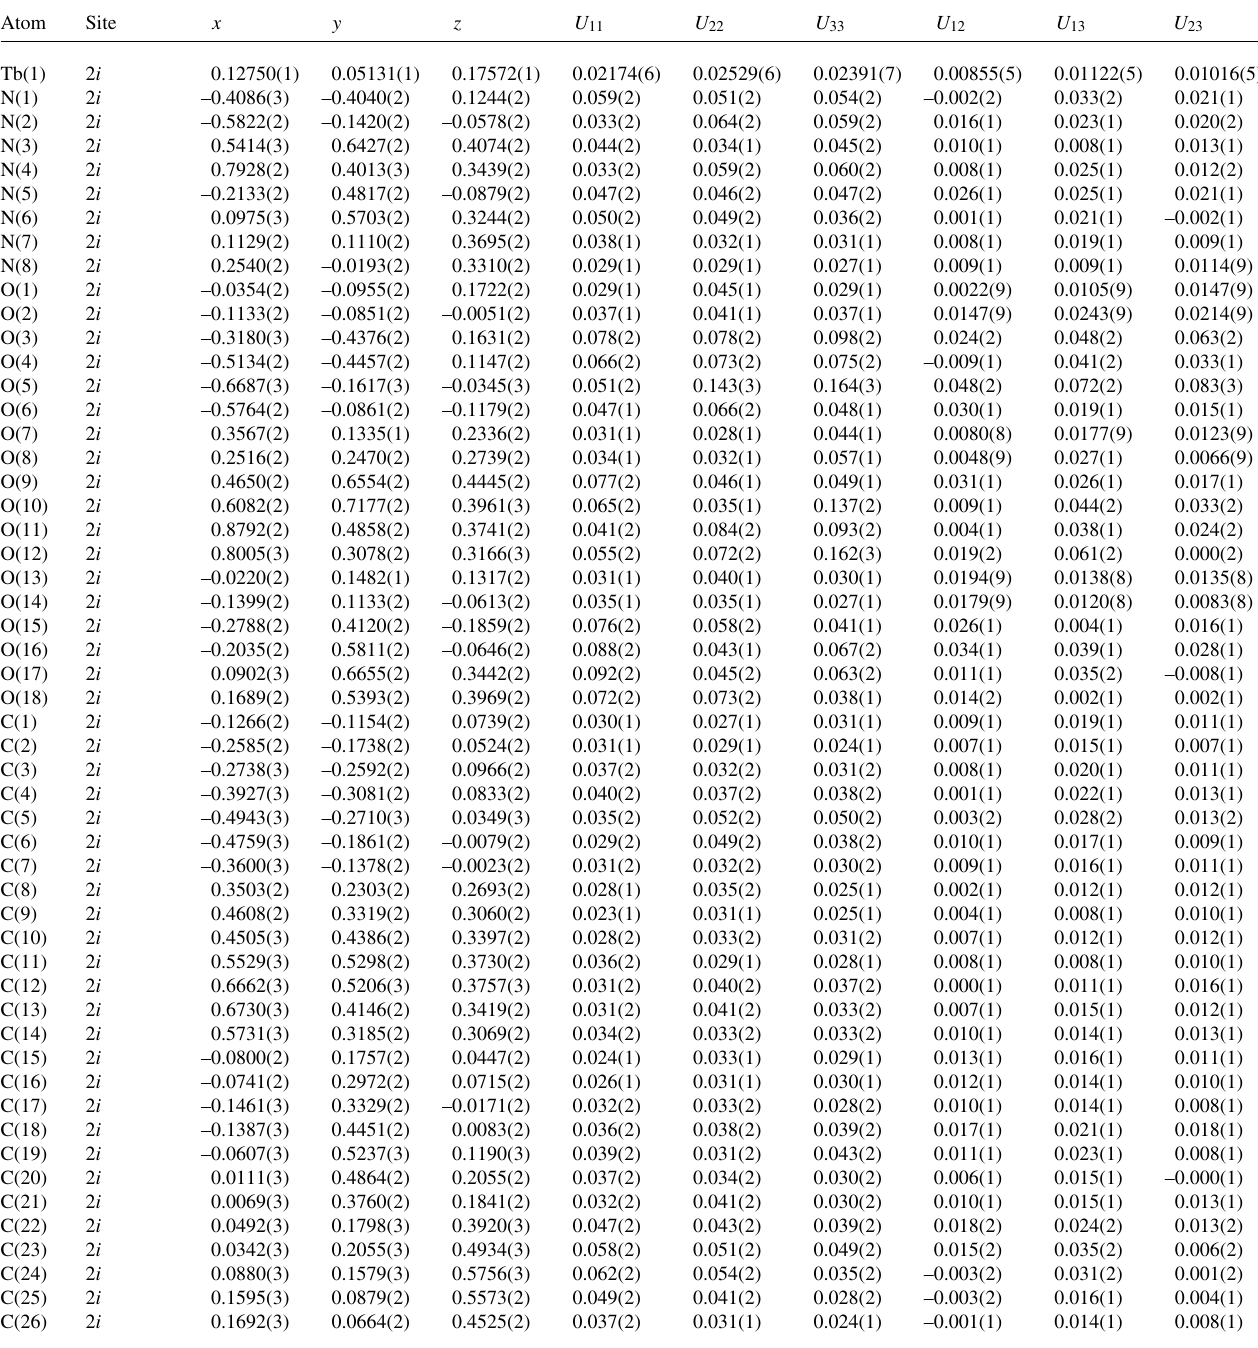
Table 3. Atomic coordinates and displacement parameters (in Å 2 ) .